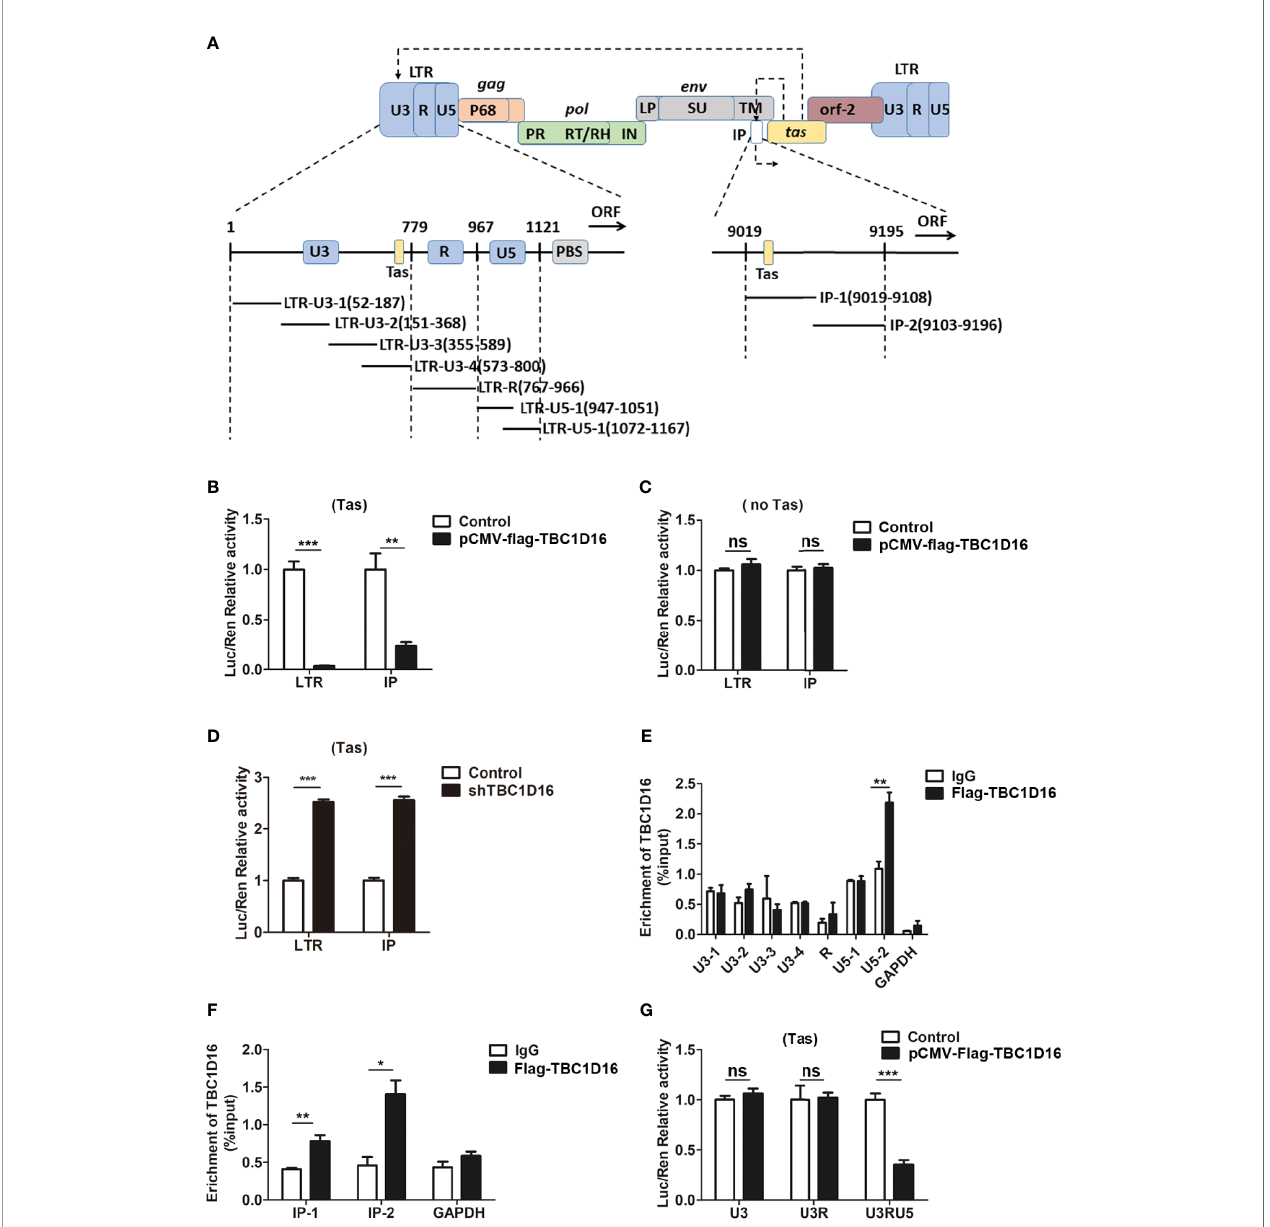
FIGURE 3 | TBC1D16 affects the Tas-dependent transactivation of the PFV LTR and IP promoters. (A) Structural diagram of PFV LTR and IP promoter. (B) HEK293T cells seeded in 24-well plates were contransfected with pCMV-Flag-TBC1D16 (400 ng, and pCMV-Flag as an empty control), pRL-TK (3 ng), and pGL3-PFV-LTR-luc (30 ng) or pGL3-PFV-IP-luc (20 ng) fi re fl y luciferase reporter. These cotransfected plasmids were combined with pTK-Tas (30 ng for pGL3-PFV- LTR-luc or 20 ng for pGL3-PFV-IP-luc). A luciferase reporter assay was used to detect LTR and IP promoter activity (Renilla luciferase as an internal control) (** p < 0.01, *** p < 0.001). (C) Luciferase assays were performed similarly as in (B) . But these cotransfected plasmids were combined without pTK-Tas ( ns , no signi fi cance). (D) The speci fi c shRNA of TBC1D16 and shControl (as a negative control), pRL-TK (3 ng), pTK-Tas (30 ng for pGL3-PFV-LTR-luc or 20 ng for pGL3- PFV-IP-luc) and pGL3-PFV-LTR-luc (30 ng) or pGL3-PFV-IP-luc (20 ng) fi re fl y luciferase reporter were transfected into HEK293T cells for 48 h. Luciferase reporter assay was used to detect the LTR and IP promoter activity (Renilla luciferase as an internal control) (*** p < 0.001). (E, F) pCMV-Flag-TBC1D16 (3 m g) and pGL3- PFV-LTR-luc (3 m g) or pGL3-PFV-IP-luc (3 m g) were cotransfected into HEK293T cells for 48 h, and ChIP assay was used to detect the enrichment of TBC1D16 on the PFV LTR and IP promoter. ChIP-qPCR data were normalized by the percent input method (%input with IgG as control). The data are presented as the means ± SD (* p < 0.05 and ** p < 0.01). (G) pCMV-Flag-TBC1D16 (400 ng and pCMV-Flag as an empty control), pRL-TK (3 ng), pTK-Tas (30 ng) and truncated pGL3-PFV- LTR-luc (30 ng) fi re fl y luciferase reporter were cotransfected into HEK293T cells for 48 h. Luciferase reporter assay was used to detect the truncated LTR promoter activity (Renilla luciferase as an internal control) (*** p < 0.001 and ns , no signi fi